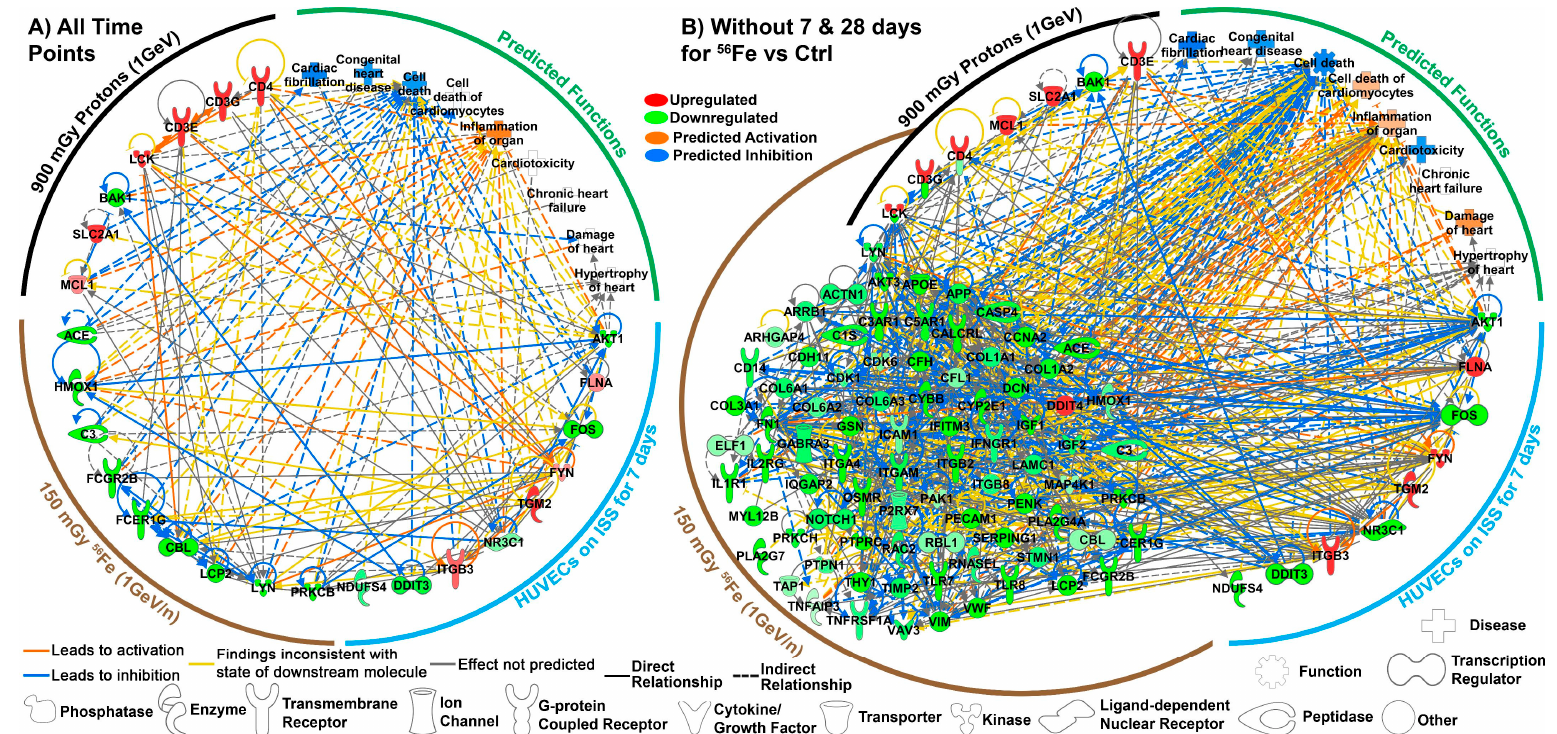
Figure 5. The key driving genes associated with space radiation and the predicted functions that these genes will affect. A circular network created with IPA is utilized connecting all the key genes from each experimental condition (i.e., common key genes for all time-points for both cardiomyocytes from mice irradiated with either 150 mGy 56 Fe or 900 mGy protons compared to 0 Gy controls and HUVECs flown in on the ISS for 7 days compared to the ground control). The color of the gene represents whether the gene is upregulated (red) or downregulated (green) with the shade signifying the degree of regulation. ( A ) The network of key genes done with analysis using all time-points and samples. ( B ) The network of key genes for analysis done with all time-points except for 7 and 28 days for 56 Fe vs Ctrl. For this analysis there were three key genes that overlapped between the cardiomyocytes irradiated with protons and 56 Fe ( CD4 , CD3G , and LCK ). These were oppositely regulated between the two irradiation conditions and the colors in the top half indicate the gene expression for protons and the bottom indicates the gene expression for 56 Fe. The different line colors represent the predicted effect of each gene on each other. Predicted functional impact of the key genes were determined using IPA which allowed us to predict whether cardiac related functions were either inhibited (blue) or activated (orange). The identification of the symbols for each gene is shown on the bottom of the figure.